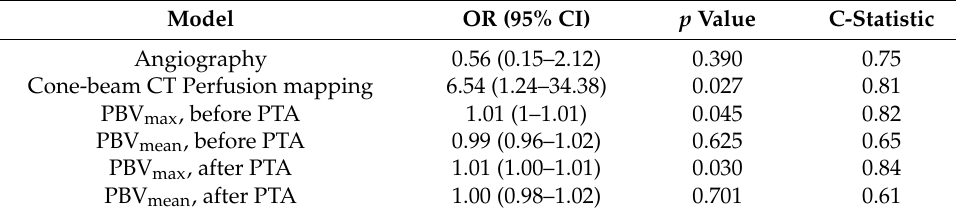
Table 5. Prediction of clinical outcome by imaging type and perfusion parameter using multiple logistic regression with C-statistics and odds ratio after adjustment for